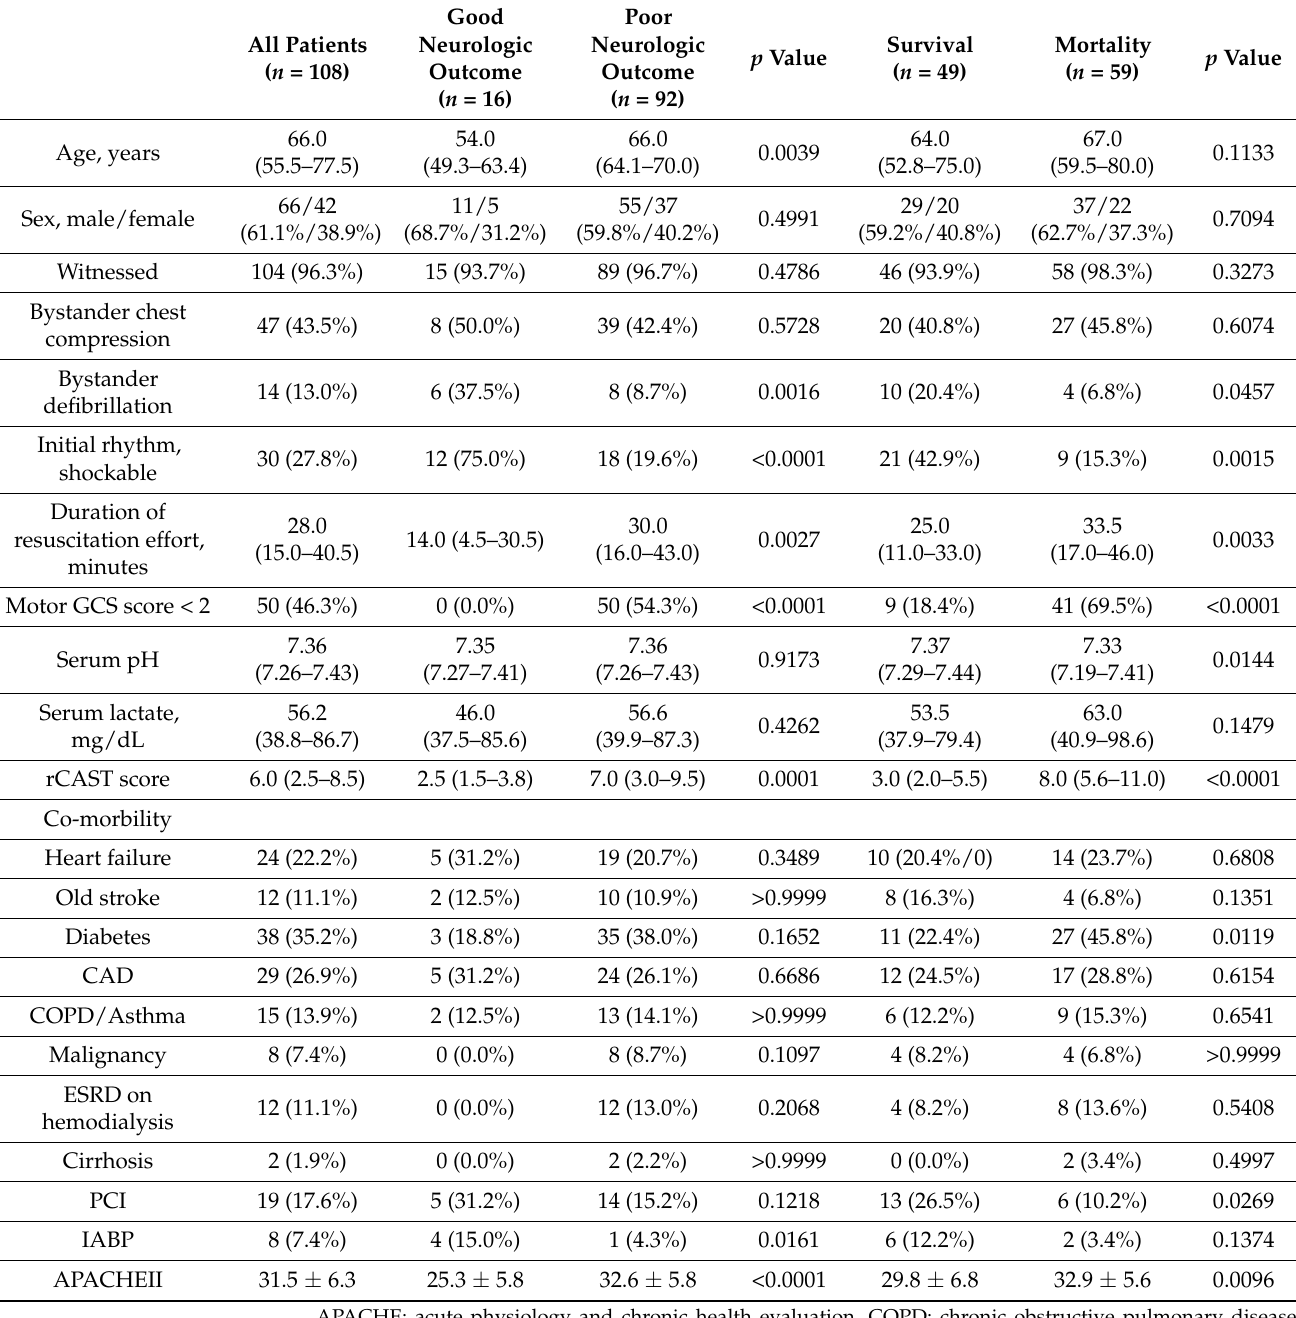
Table 1. Basic characteristics and comparison between different hospital